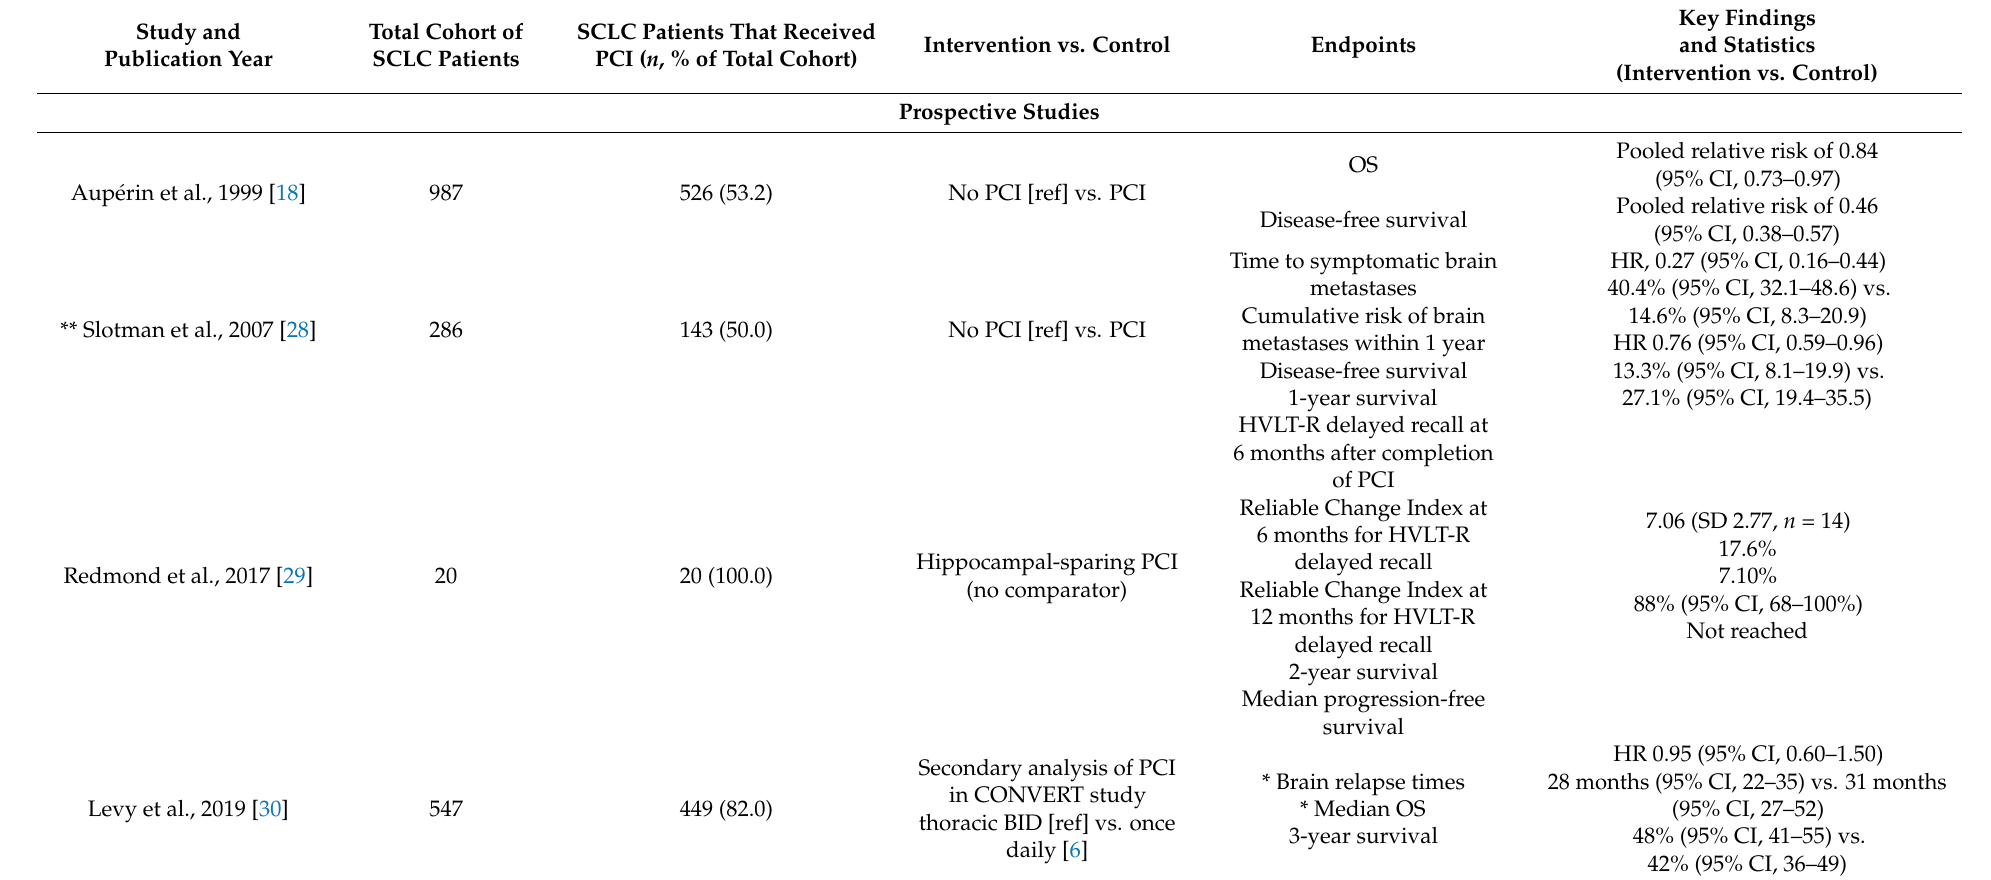
Table 2. Various recent studies that detail the utility of PCI in LS-SCLC with study information and key